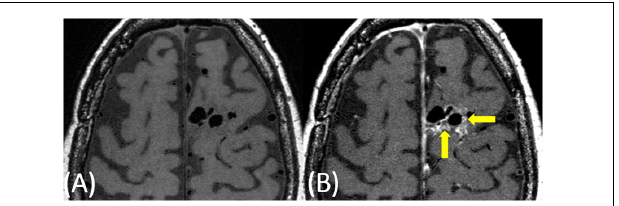
FIGURE 1 | 51-year-old man with a large AVM centered in the right temporoparietal lobe. On pre-contrast VW-MRI (A) , no intrinsic T1 hyperintensity is present. On post-contrast VW-MRI (B) , there were multiple areas of hyperintensity at the vessel wall within the nidus (yellow arrows).